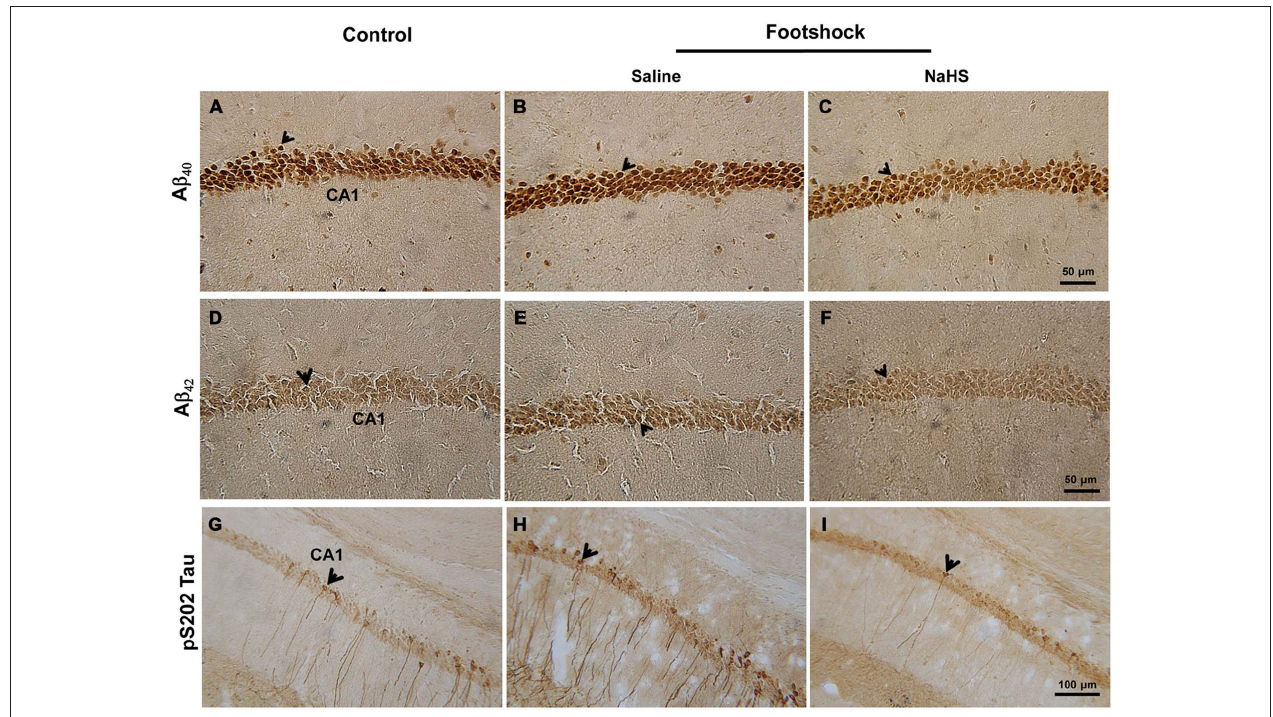
FIGURE 7 | NaHS decreased the levels of A β and phosphorylated tau protein in the hippocampal CA1 subregion of the footshock-stimulated mice. (A–F) Representative immunostaining for A β 40 and A β 42 in area CA1 of the mouse hippocampus. Scale bar = 50 µ m. (G–I) Representative immunostaining for tau protein phosphorylated at S202 (pS202 Tau) in area CA1 of the hippocampus. Scale bar = 100 µ m. The arrowheads indicated positive staining for A β 40 , A β 42 , and pS202 Tau ( n = 3–5 per group).